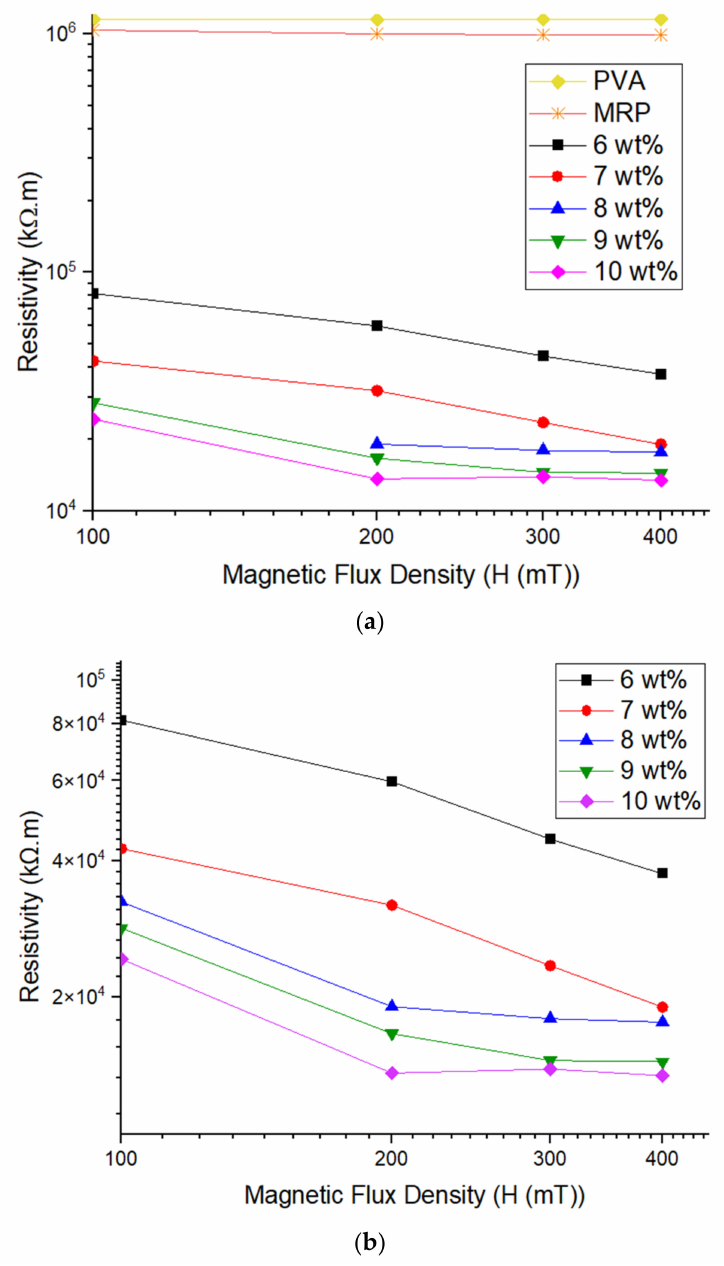
Figure 7. Resistivity trends of PVA, MRP, and five different weight percentages of Gr–MRP. ( a ) Resis- tivity of all samples and ( b ) enhanced resistivity scale for samples with different Gr contents under different magnetic flux